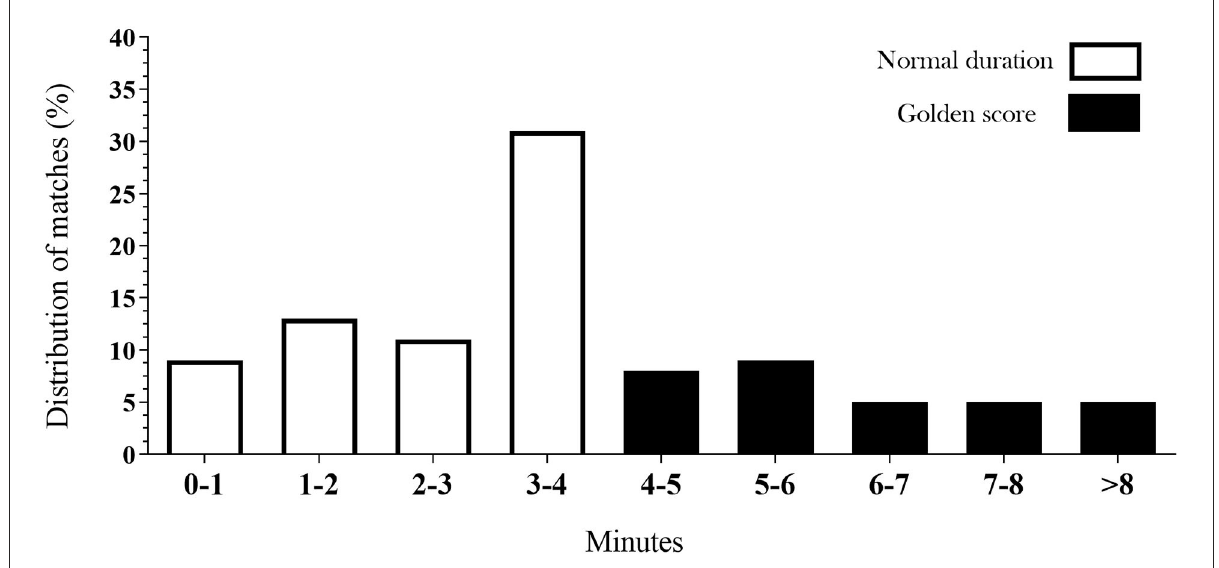
FIGURE1 Distribution of matches according to the regular ( ≤ 4min) and the golden score ( > 4min) durations.